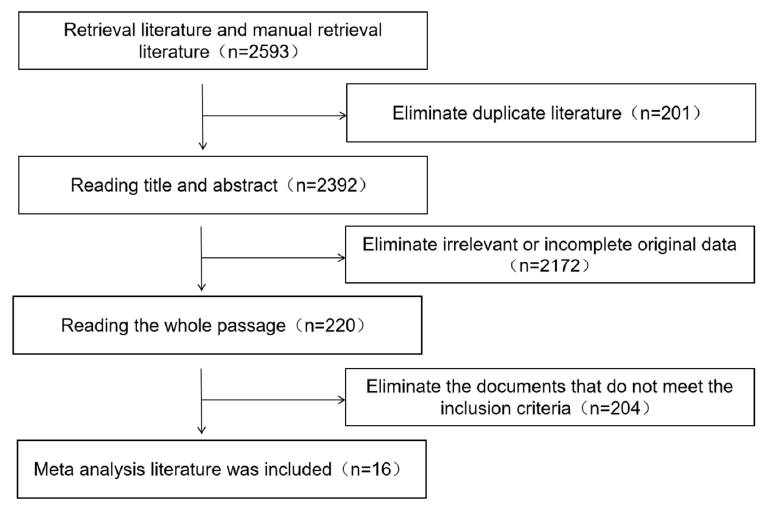
Figure 1. The flowchart of the literature retrieval and